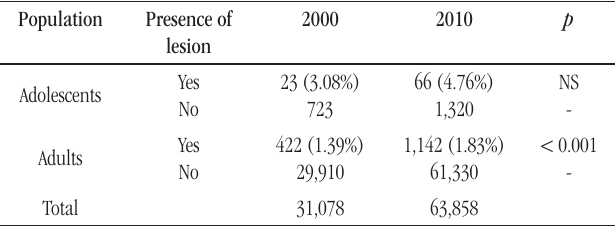
taBLE 1 – Comparison of cervical cytology test reports, with and without lesion, from adolescent and adult women in 2000 and 2010